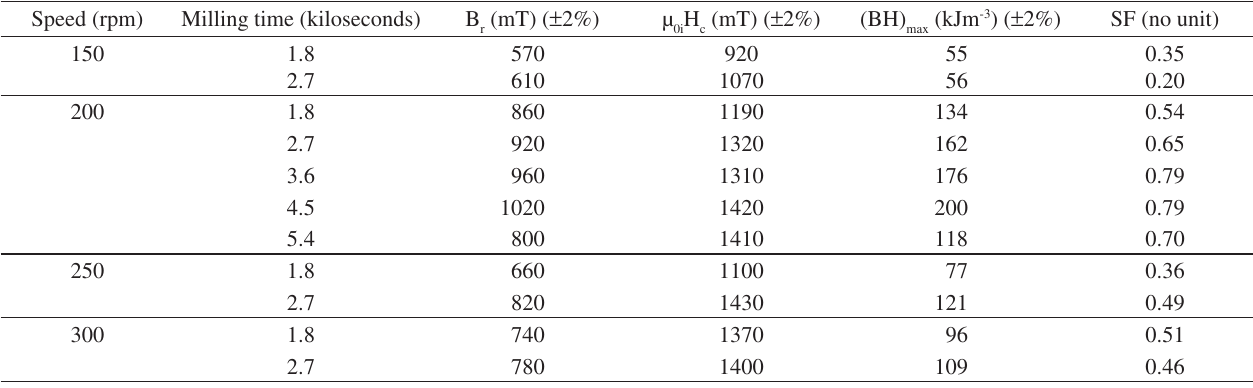
Fe B HD sintered magnets. 16 76 8